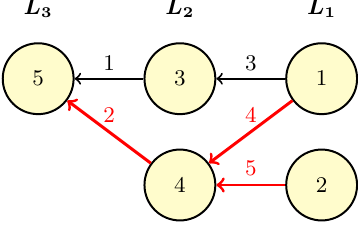
Figure 6. An example of a weighted and directed